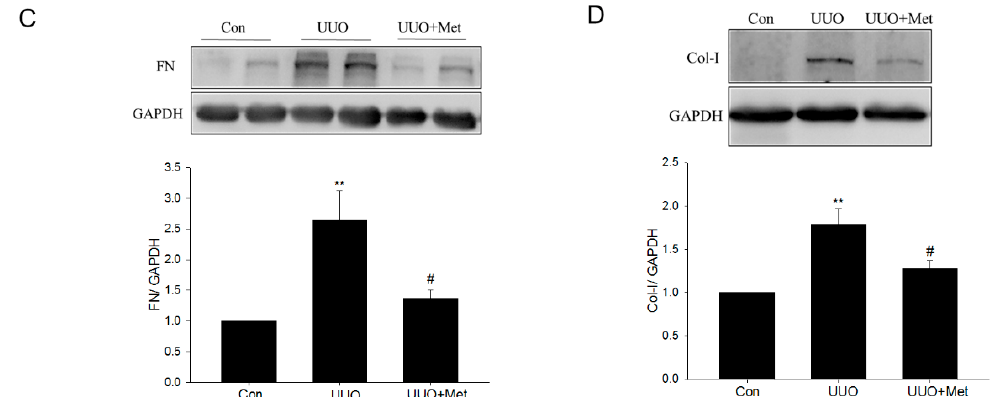
Figure 2. The effect of metformin on extracellular matrix (ECM) production in unilateral ureteral obstruction mice. ( A , B ) The time course of fibronectin and collagen I in unilateral ureteral obstruction (UUO) mice, at three and seven days, visualized by Western blotting; ( C , D ) The levels of fibronectin (FN) and collagen I (Col-I) were analyzed by Western blotting after metformin treatment. Data are the mean ± SEM for six animals. * p < 0.05, ** p < 0.01 compared with control (Con); # p < 0.01 compared with UUO with vehicle (UUO).